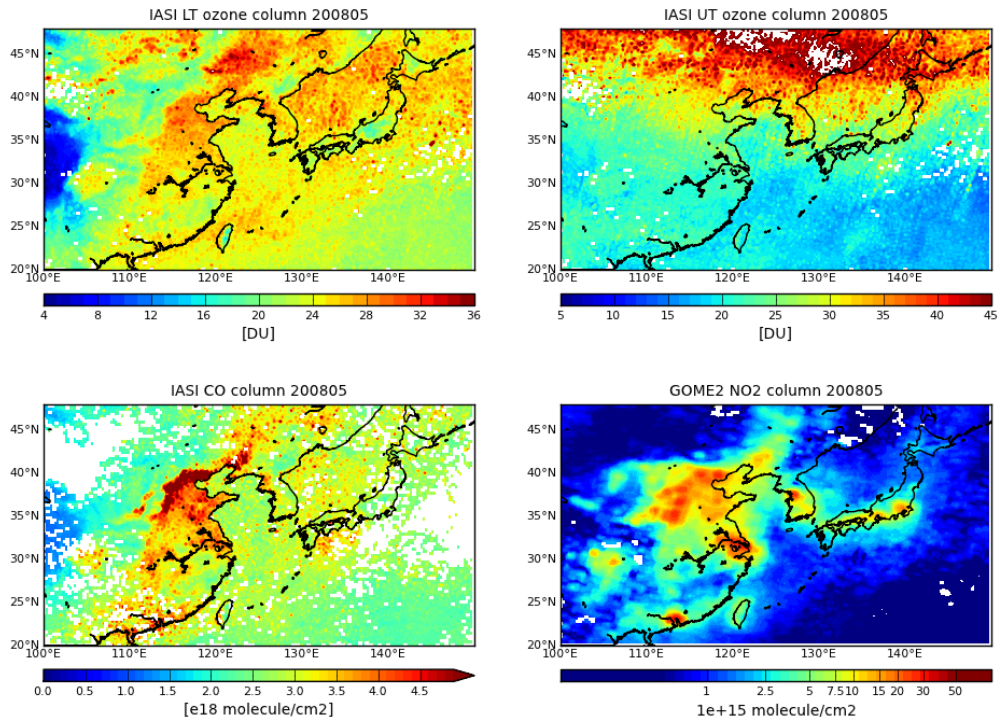
Figure 9. Monthly lower (upper left) and upper (upper right) tropospheric ozone columns observed by IASI in May 2008 as well as monthly IASI total CO columns (lower left) and GOME-2 NO 2 tropospheric columns (lower right) observed in May 2008. The average is calculated for a 0.25 ◦ × 0.25 ◦ resolution